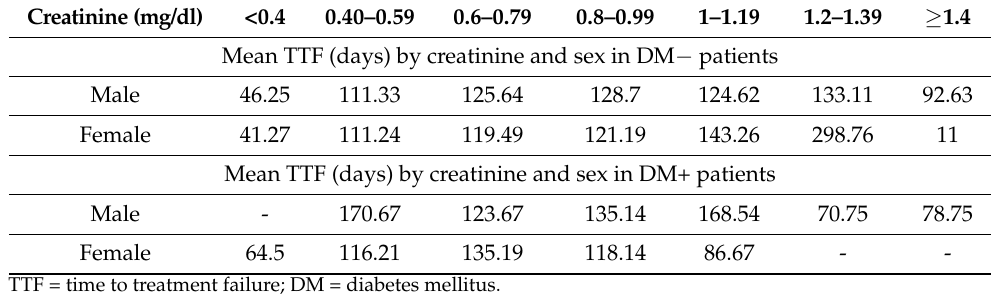
TTF = time to treatment failure; DM = diabetes mellitus.